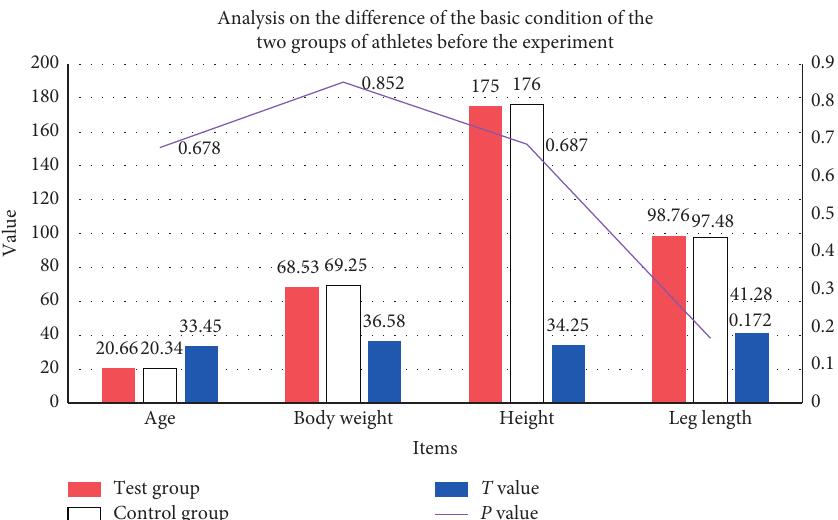
Figure 2: Analysis of the difference of the basic condition of the two groups of athletes before the